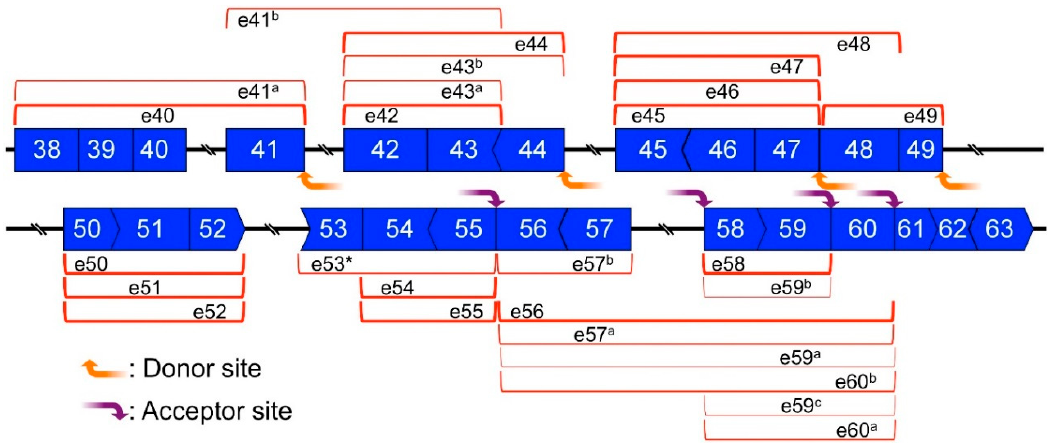
Figure 6. Mapping of small circRNAs. Divergent reverse transcription-polymerase chain reaction (RT-PCR) experiments were performed using skeletal muscle cDNAs and a primer set for each exon (exon 40–60). Highly expressed small circRNAs or equally highly expressing circRNAs are shown as round red brackets. Donor and acceptor sites of multiple exon skipping (MES) are indicated by orange and purple arrows, respectively. Bold lines indicate post-transcriptional introns.